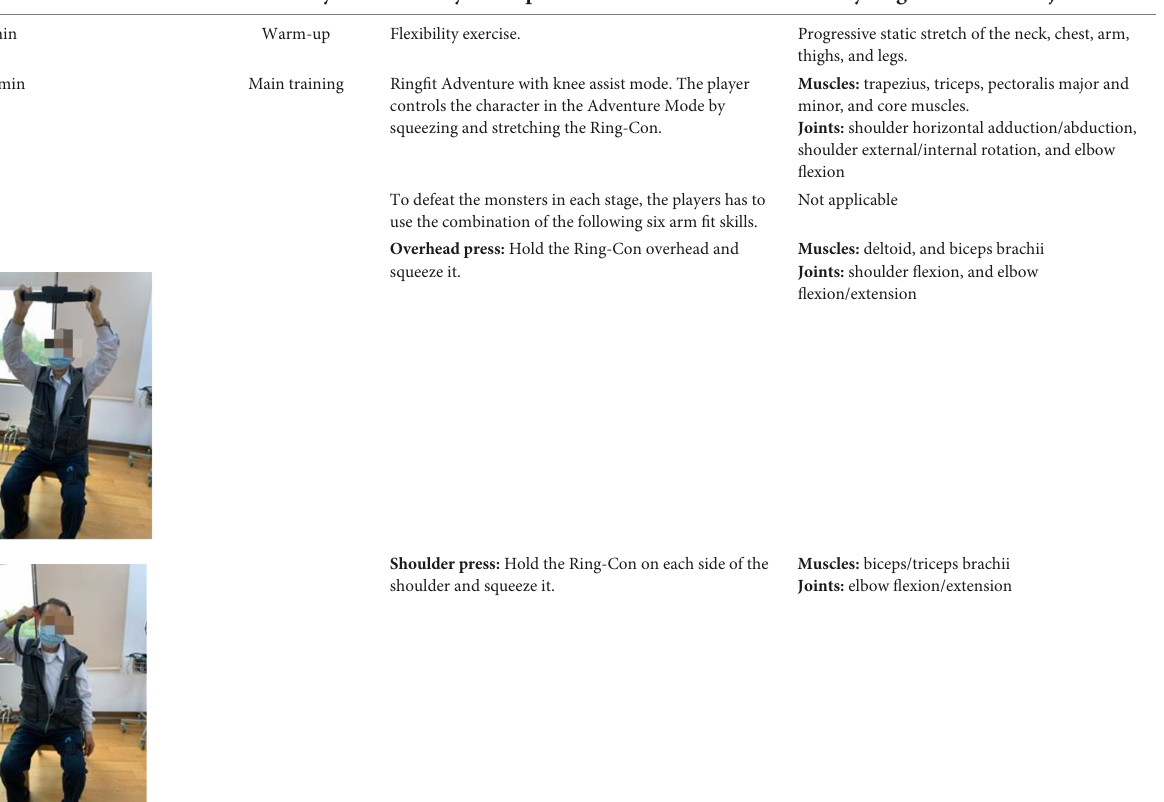
Frontpress: Hold the Ring-Con below umbilicus with anterior-tilting of the trunk slightly.